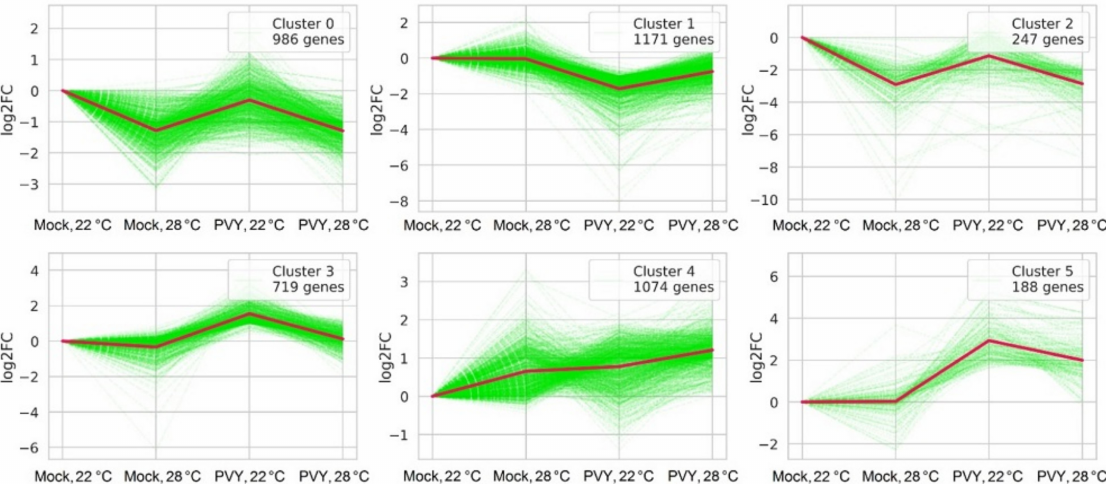
Figure 3. Differentially expressed genes: k-means clustering of DEGs based on log 2 FC values. Green lines represent individual genes, red lines mean log 2 FC cluster